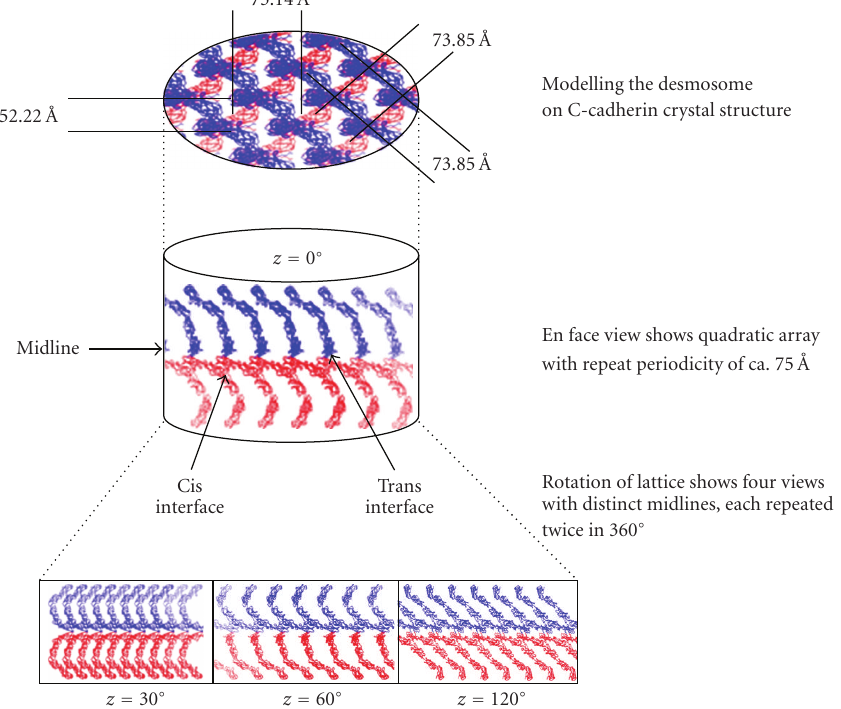
Figure 5: Schematic representation of the Dsc2 ectodomain model 3D array, generated from the crystallographic structure of C-cadherin [56]. In the centre we represented the desmosomal interspace as a cylinder, showing the midline formed by trans and cis interactions between molecules on opposed cell surfaces. Monomers from one cell surface are coloured in red and monomers from the opposed cell surface are coloured in blue. The midline is aligned with the x -axis of the cylinder (coincident with the x -axis in the crystallographic lattice). Rotation of the 3D array around the x -axis by 90 ◦ (top) shows a regular lattice with distances between rows of molecules of 73.85 and distances of 75.14 between layers. Rotations around the z -axis produce four di ff erent views, all of them with a midline dense zone (bottom). These are strand dimer1 at z = 0 ◦ , “boat” at z = 30 ◦ , strand dimer 2 (inverse form strand dimer 1) at z = 60 ◦ , and “zipper” at z = 120 ◦ . The cis and trans interfaces between distal domains are indicated by arrows. Reproduced from the study by Garrod et al. in